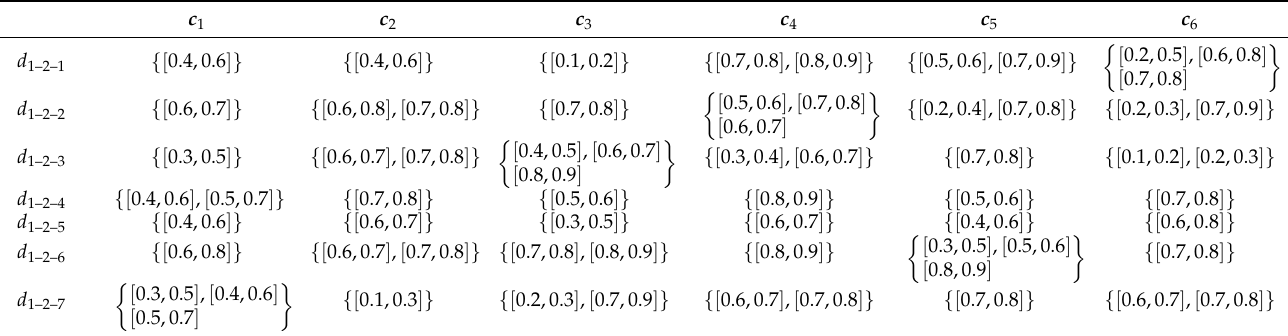
Table A2. Scoring matrix of profitability d 1–2 .